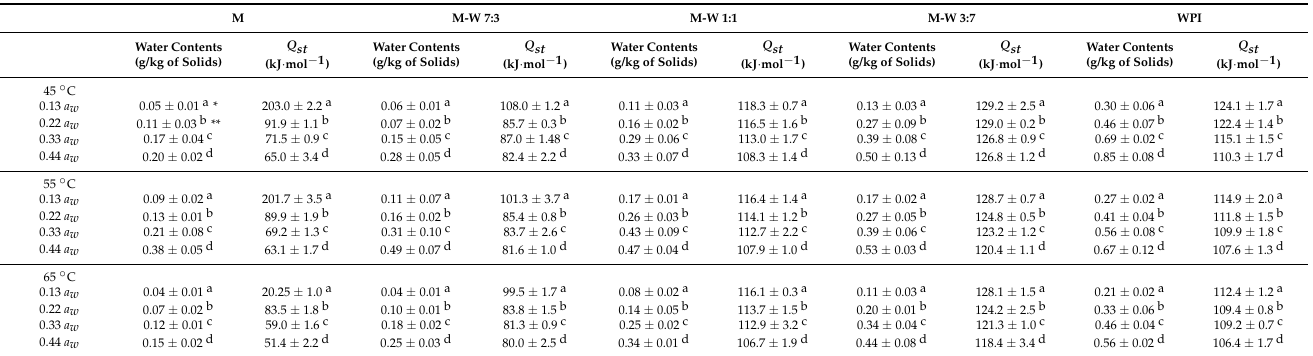
Table 1. The Q st in pure amorphous maltose (M) and maltose/WPI (M-W) mixtures at the studied storage conditions (0.13 to 0.44 a w and 45 to 65 ◦